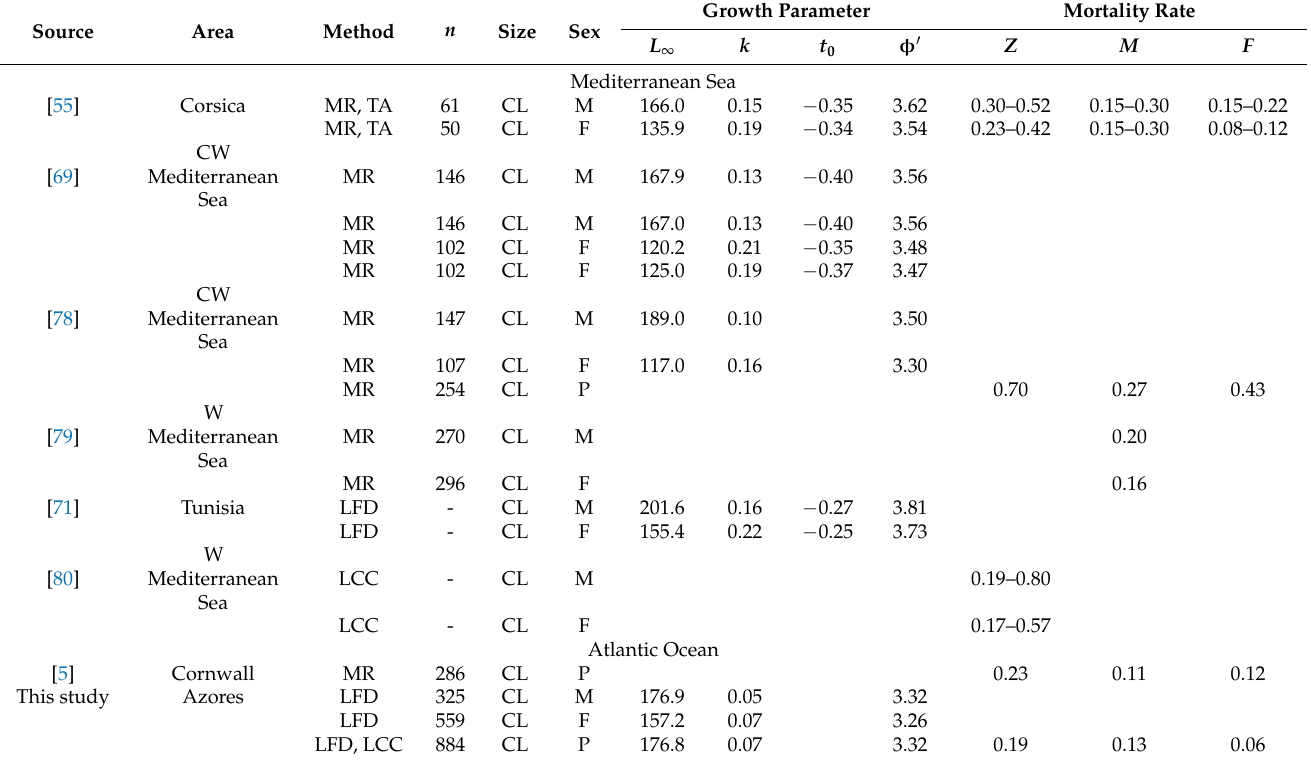
Table 4. Summary of growth and mortality studies of Palinurus elephas . MR: mark–recapture; LCC: length–converted catch curve; LFD: length–frequency analysis; TA: theoretical arguments; n : number of individuals; CL: carapace length; P: pooled sexes; M: males; F: females; L ∞ : asymptotic length (cm); k : growth coefficient (year − 1 ); t 0 : theoretical age at length zero; φ (cid:48) : growth performance index; Z : total mortality rate (year − 1 ); M : natural mortality rate (year − 1 ); F : fishing mortality rate (year − 1